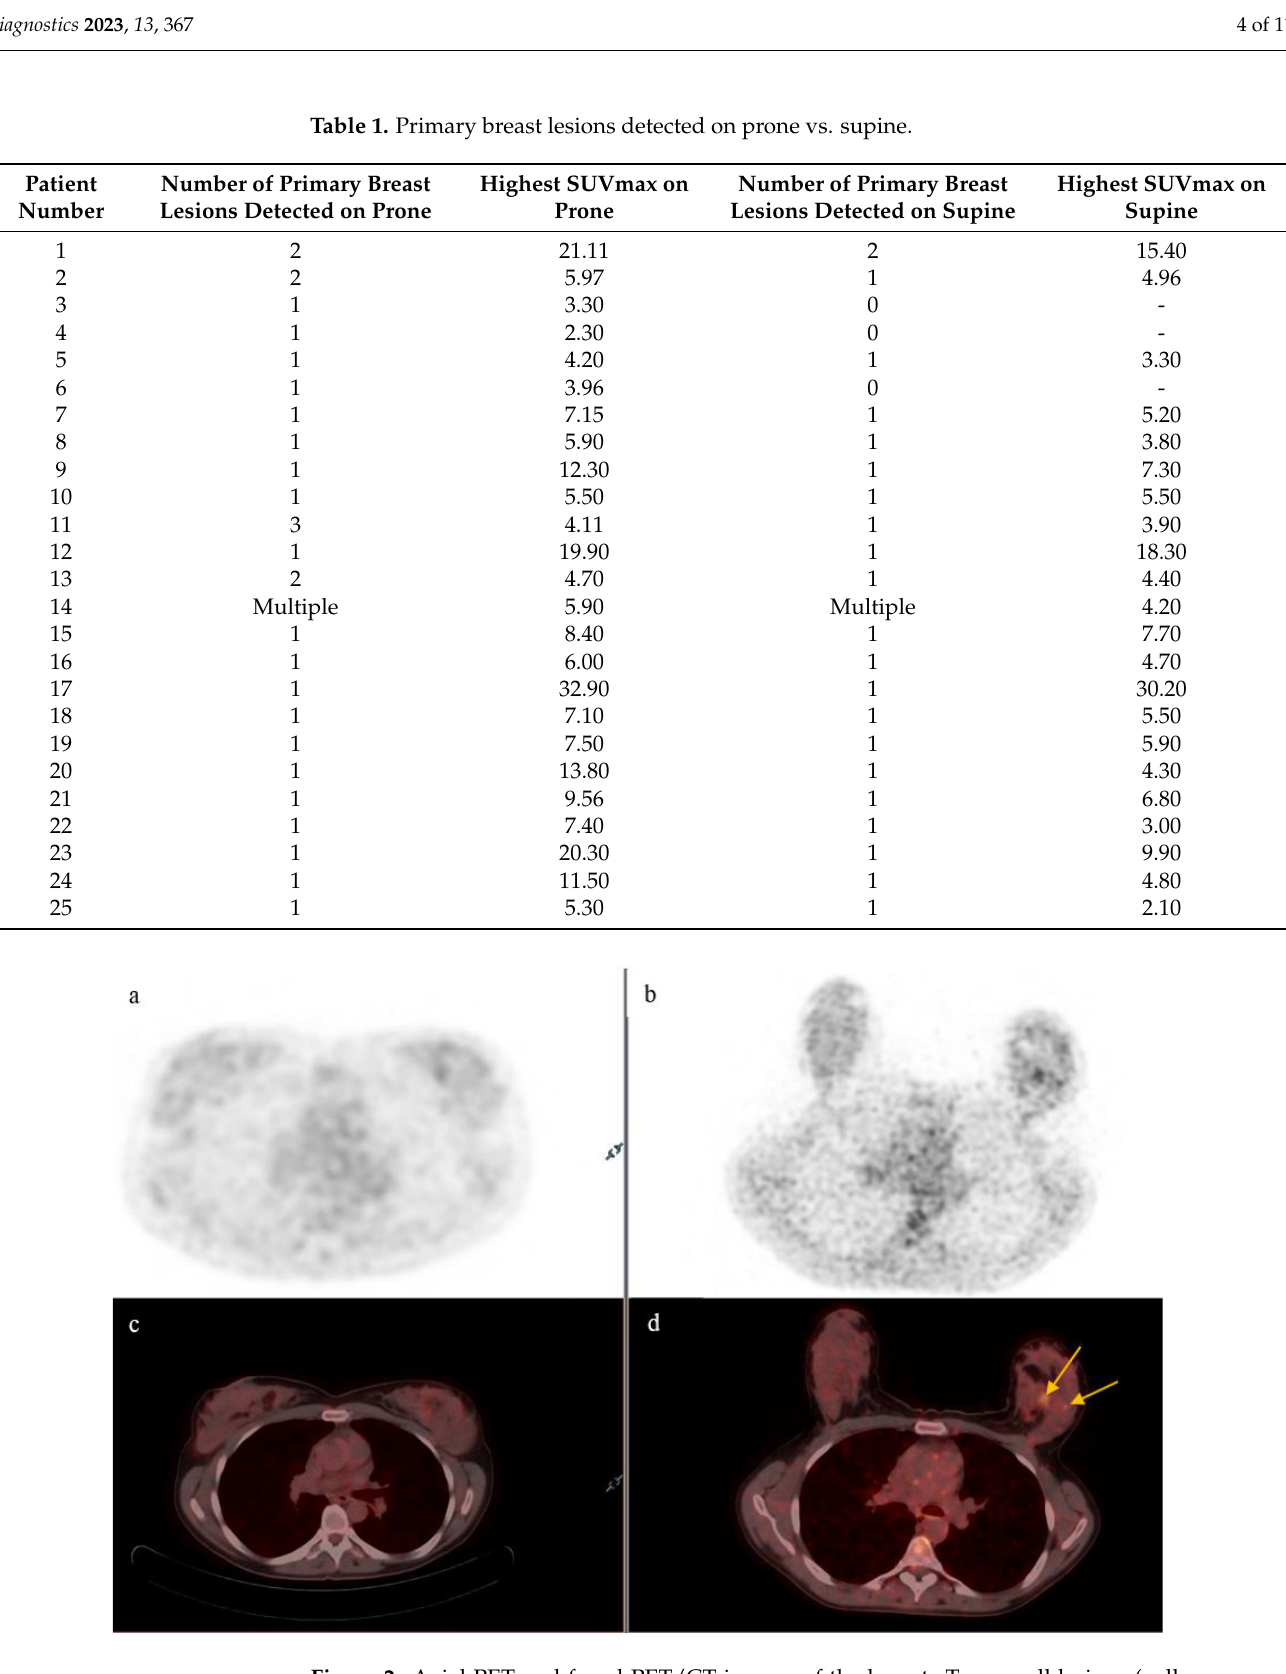
Figure 2. Axial PET and fused PET/CT images of the breast. Two small lesions (yellow arrows) are visualized within the left breast in prone acquisition ( b , d ), corresponding to multi-focal disease. Supine acquisition ( a , c ) showing single focal uptake in the left breast .